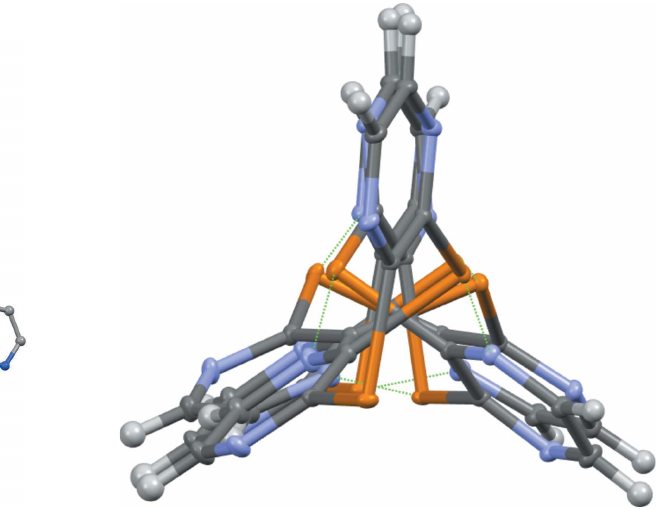
Figure 2 The unit cell, showing intermolecular Te (cid:2)(cid:2)(cid:2) N contacts.